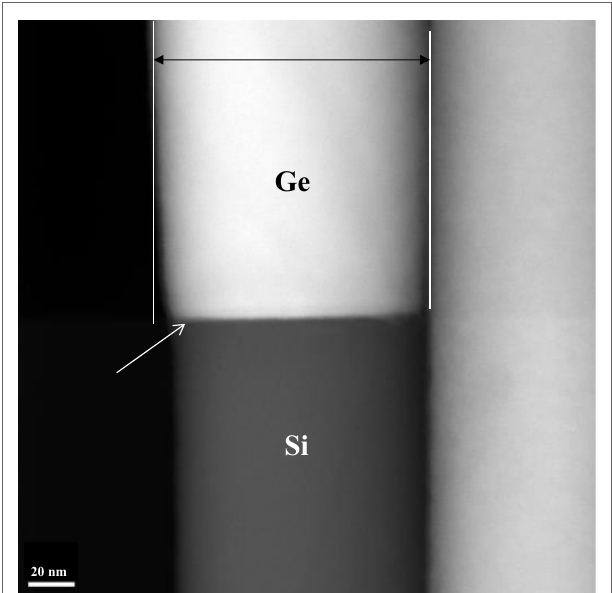
FiGURe 3 | Transmission electron microscope (TeM) image of the axial Si/Ge nanowire (Nw) heterojunction (HJ) showing an abrupt Si/ Ge heterointerface (marked by the arrow) and an increase in the Nw diameter from 105 nm in the Si segment to 115 nm in the Ge segment of the Nw (wang et al., 2015) .